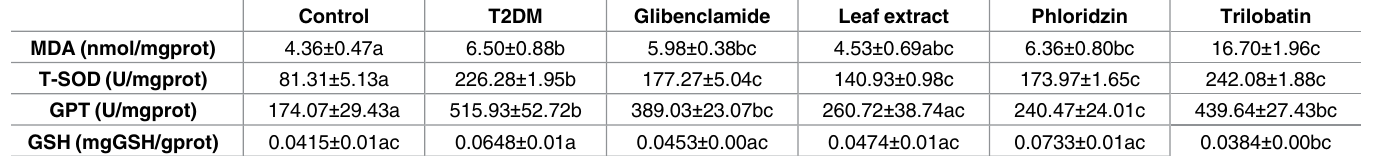
Table 1. Hepatic biochemical indexes levels of malondialdehyde (MDA), superoxide dismutase (T-SOD), glutamate pyruvate transaminase (GPT), or glutathione (GSH) in mice following 4 weeks of treatment with glibenclamide, leaf extract,phloridzin, or trilobatin.